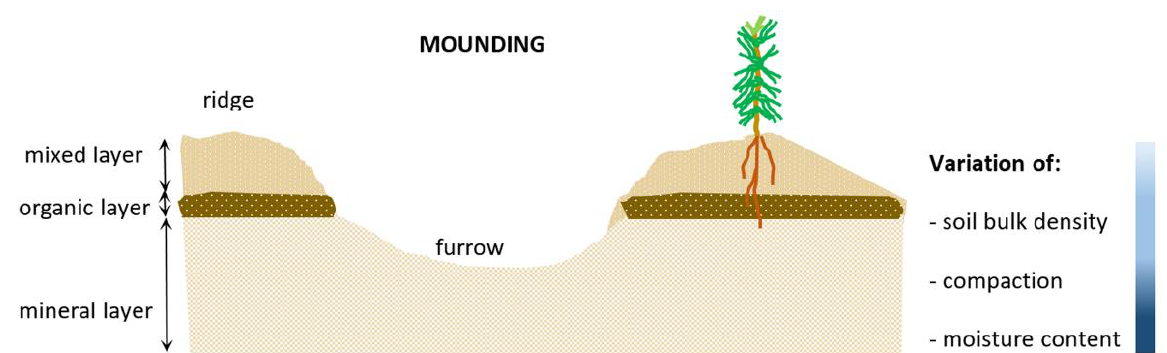
Figure 9. Profile of the disturbed soil after forest site preparation (mounding)